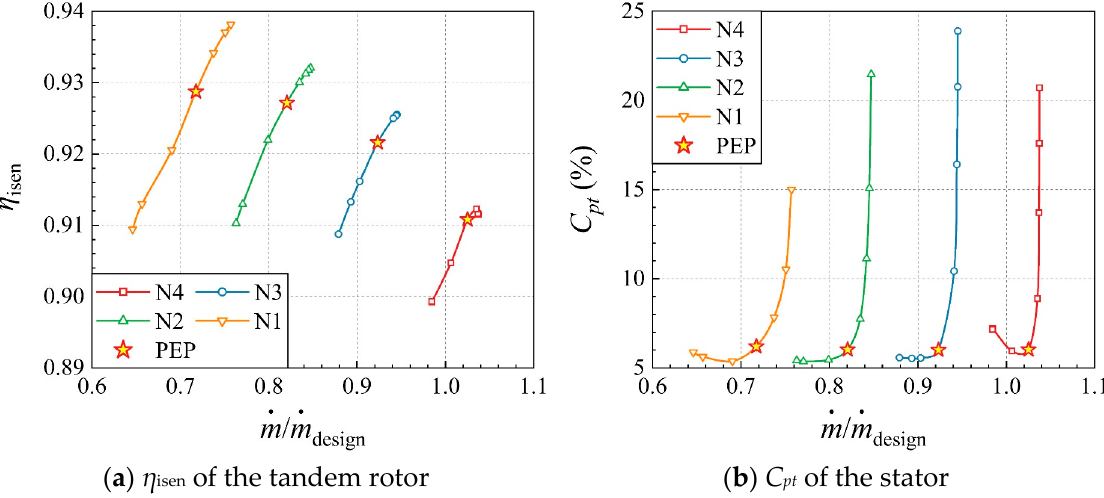
Figure 15. Aerodynamic performance of various components at N1, N2, N3, and N4.